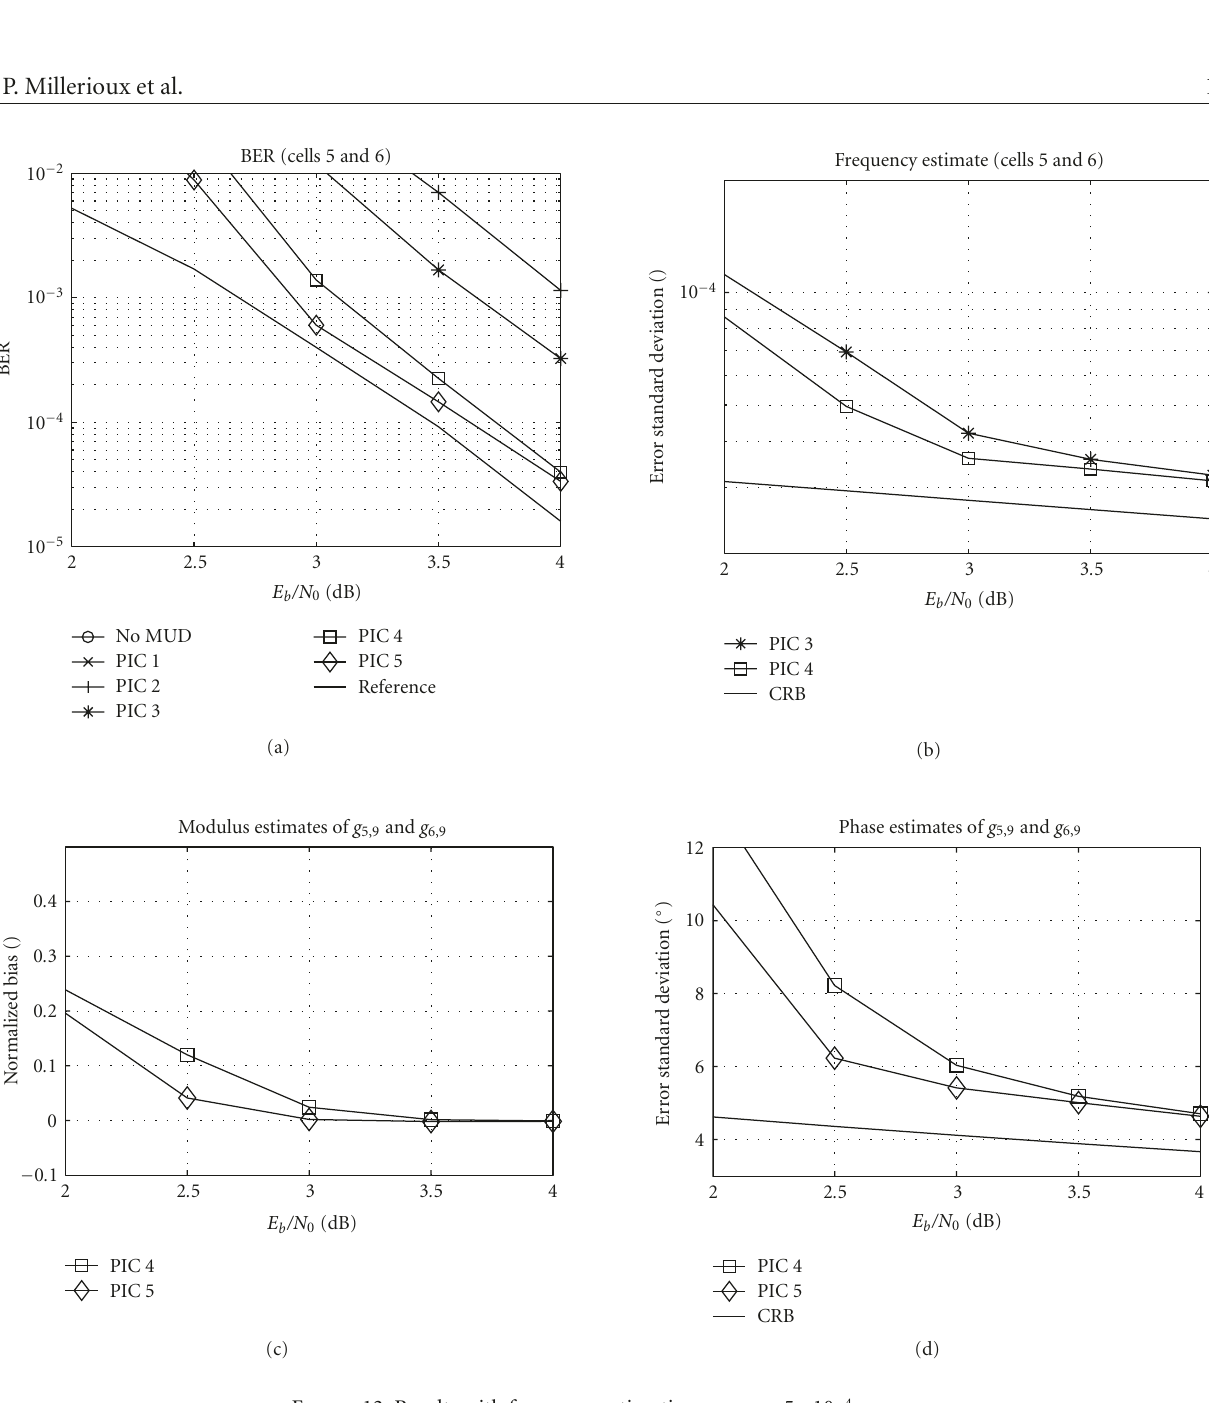
Figure 12: Results with frequency estimations: σ Δ fT = 5 · 10 − 4 , case